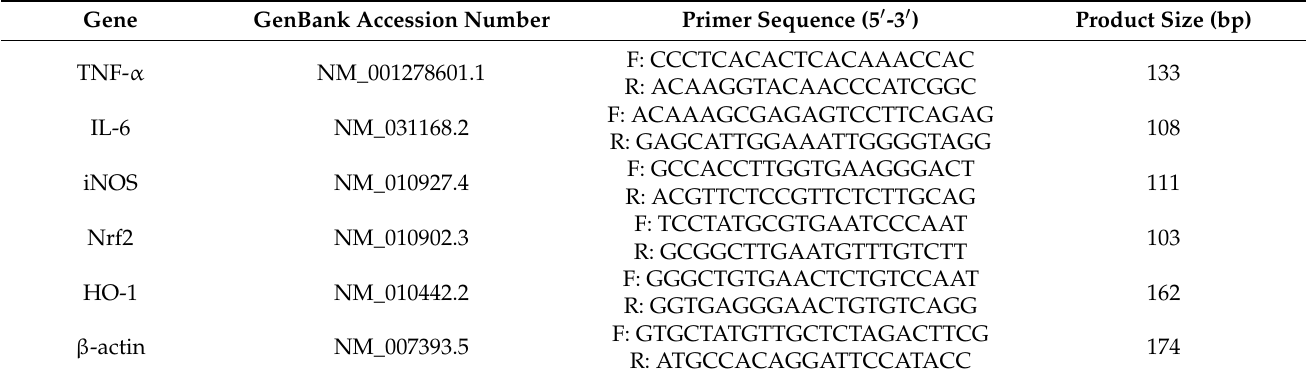
Table 1. Primers used for quantitative real-time polymerase chain reaction (qRT-PCR). Gene GenBank Accession